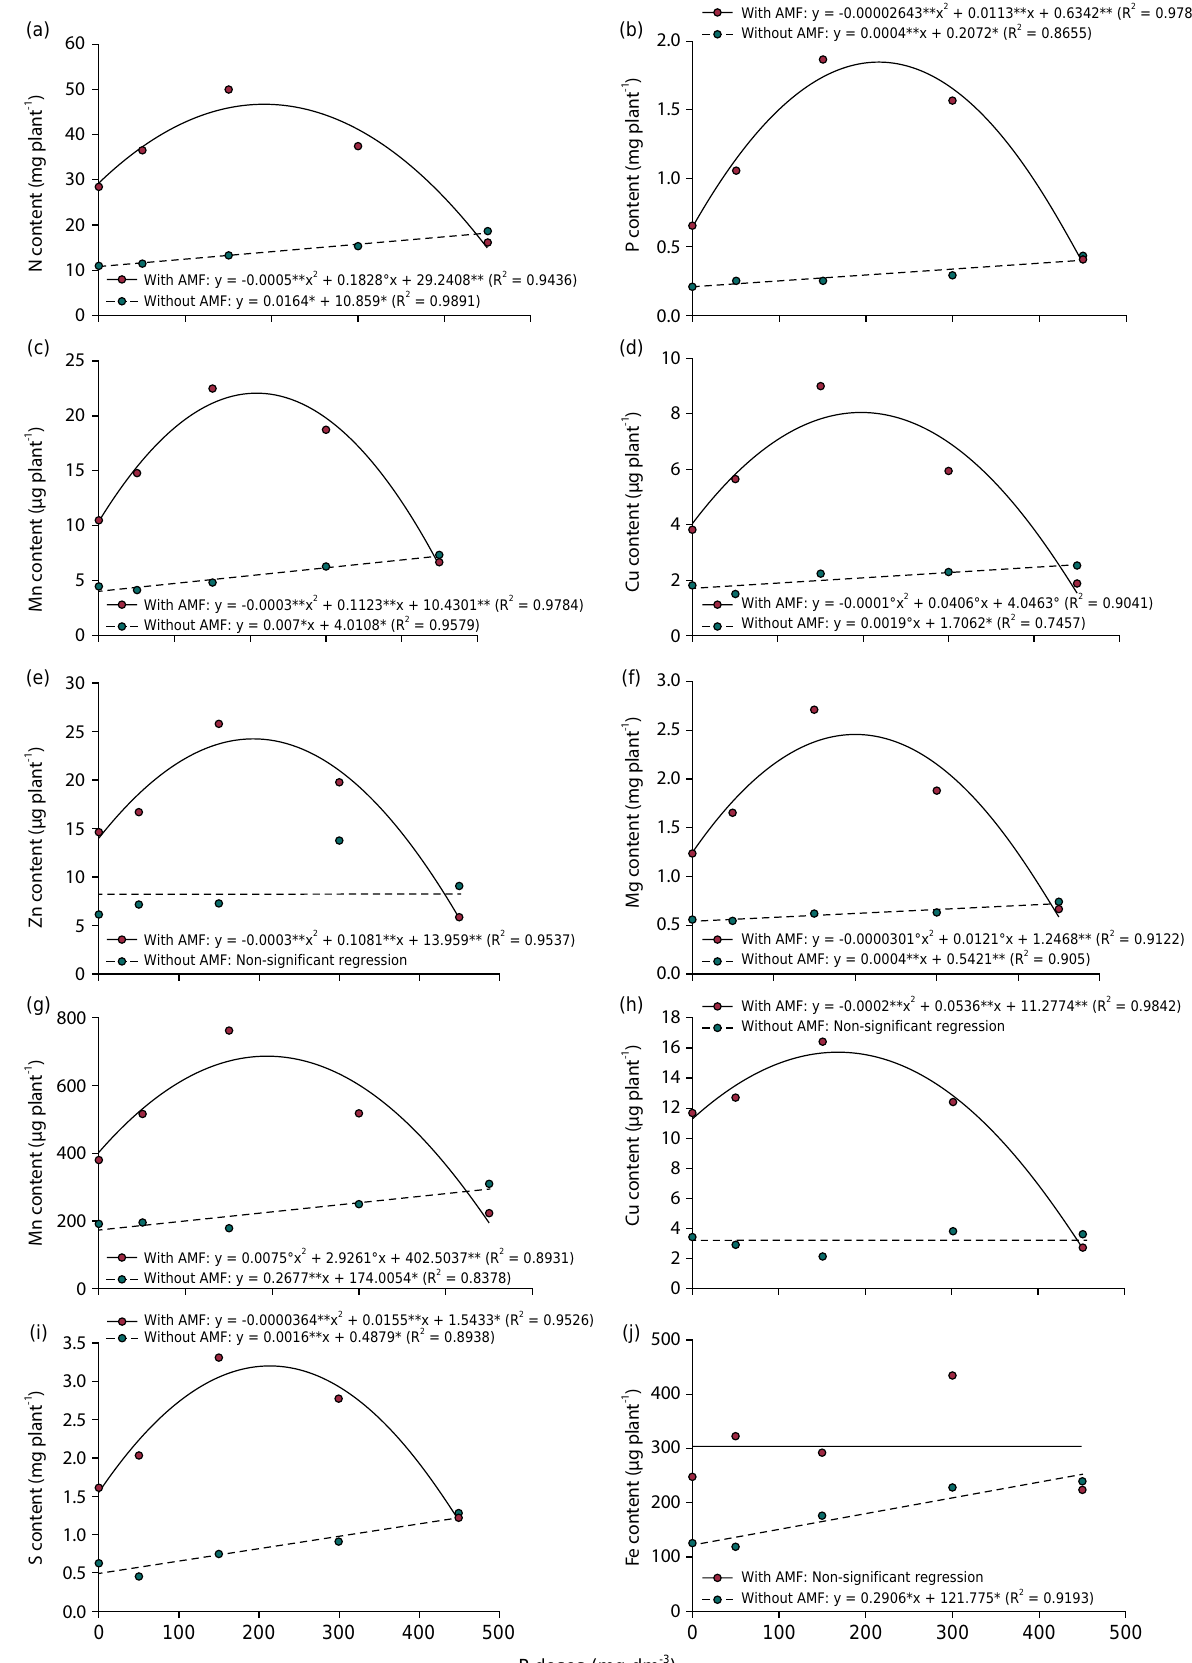
Figure 2. Nutrient content (a) N, (b) P, (c) K, (d) Ca, (e) Zn, (f) Mg, (g) Mn, (h) Cu, (i) S, and (j) Fe of P . reticulata seedlings after 90 days of cultivation, fertilized with P (0, 50, 150, 300, and 450 mg dm -3 ) and inoculated or uninoculated with species of arbuscular mycorrhizal fungi ( Claroideoglomus etunicatum , Rhizophagus clarus , Gigaspora albida ). The indicative levels of significance of the regression coefficients in the equations were presented as *, **, and ° corresponding to 0.01, 0.05, and 0.10 probability,